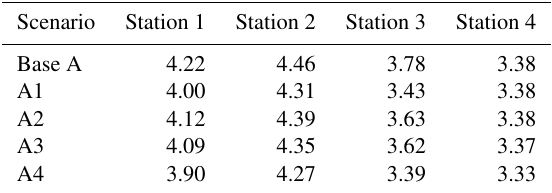
Table 3. Peak water levels at the four representative stations under the five scenarios considered in this study (unit: